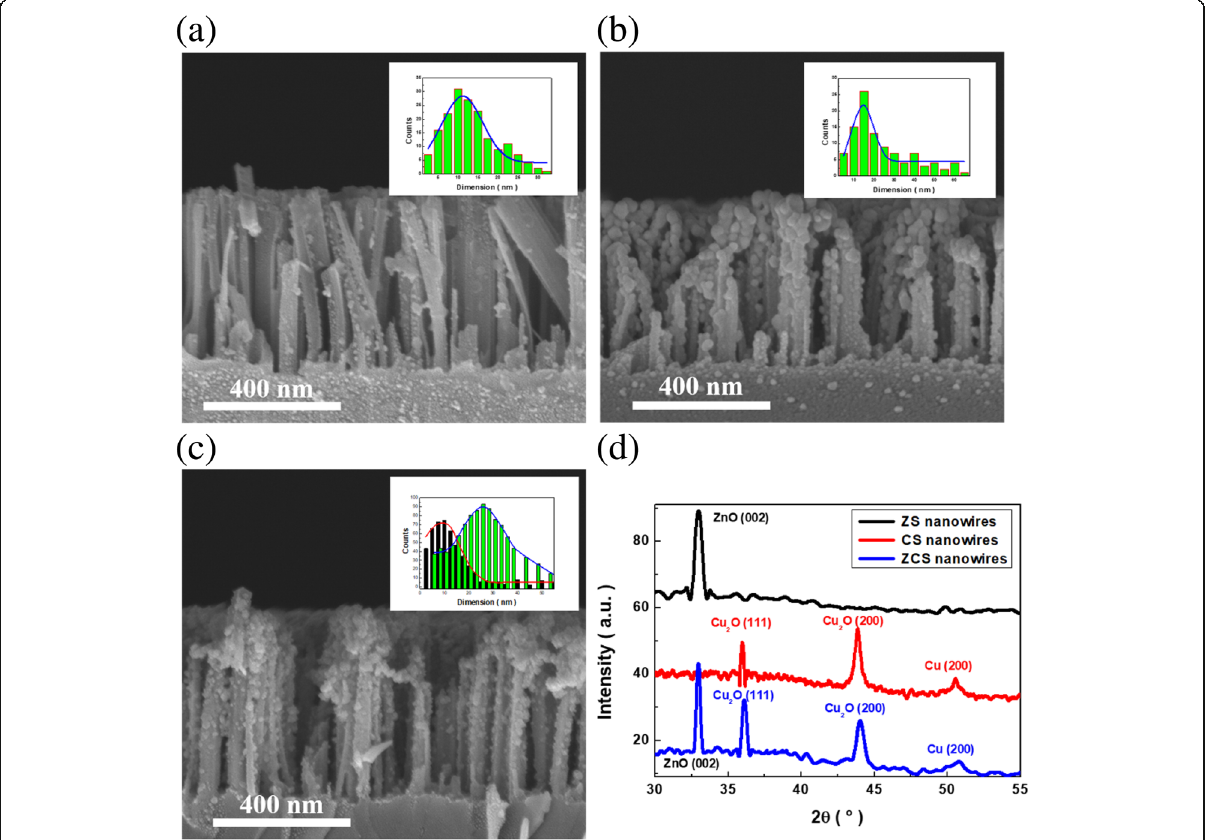
Fig. 1 Cross-sectional SEM images of the synthesized heterostructures: a ZS, b CS, and c ZCS nanowire arrays. The inserted figures displayed the diameter distribution of the prepared samples, respectively. d XRD patterns of ZS nanowires, CS nanowires, and ZCS nanowires,